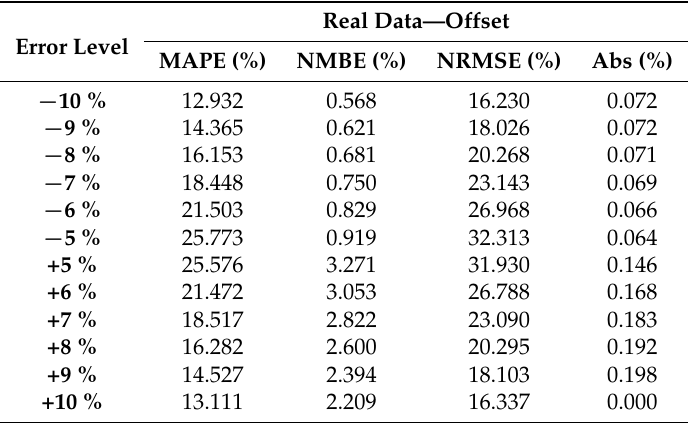
Table 4. Error indicators for different offset error levels—Real data.